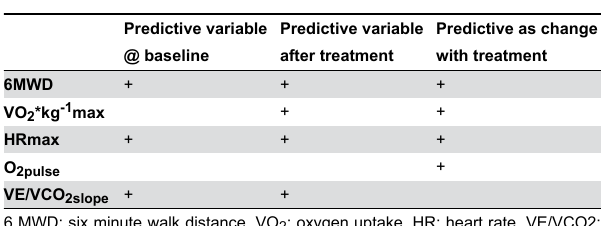
Table 3. Prognostic relevance by Kaplan-Meier analysis of exercise variables determined at baseline and after treatment, and measured as change with treatment.